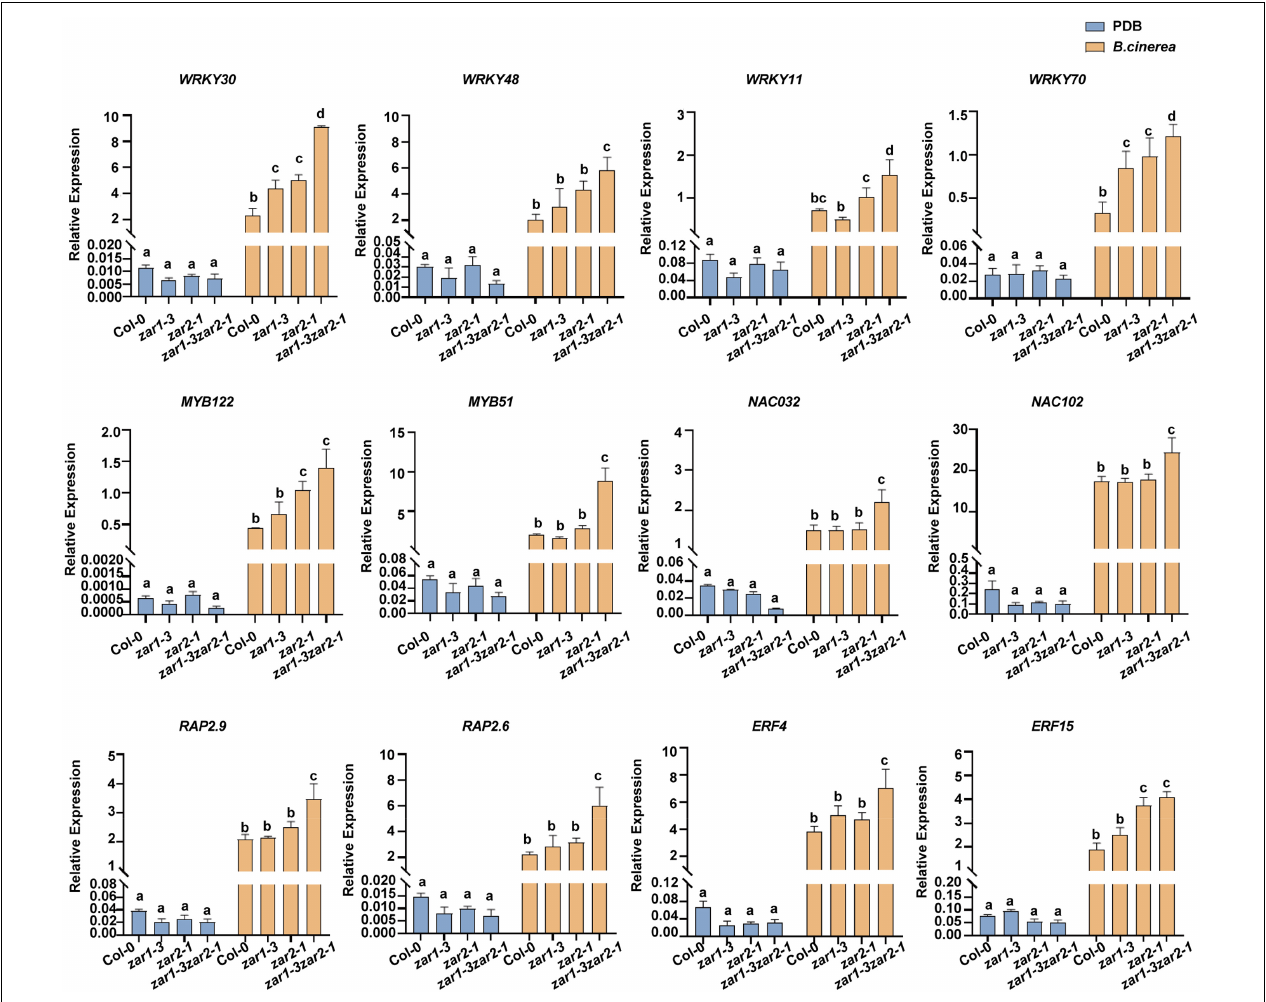
FIGURE 6 | The relative expression levels of defense-related transcription factor genes induced by B. cinerea were enhanced in zar1-3zar2-1 double mutant. The relative expression levels of defense-related transcription factor genes upon B. cinerea infection or PDB treatment were evaluated in zar1-3 mutant, zar2-1 mutant, zar1-3zar2-1 double mutant, and Col-0 plant. Twelve-day-old seedlings were inoculated with B. cinerea spores or PDB for 28 h. The relative expression levels of defense-related TF genes were analyzed by qPCR, UBQ5 was used as an internal control. The relative expression was calculated by the transcription level of each gene relative to UBQ5 upon B. cinerea or PDB treatment. The different letter indicates significant difference ( p < 0.05), as determined by one-way ANOVA with Tukey’s